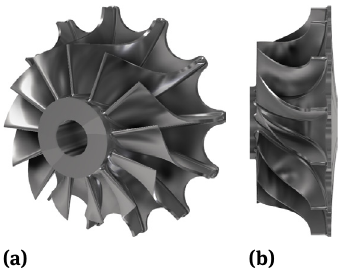
Figure 20: Turbine disc 3D model (after